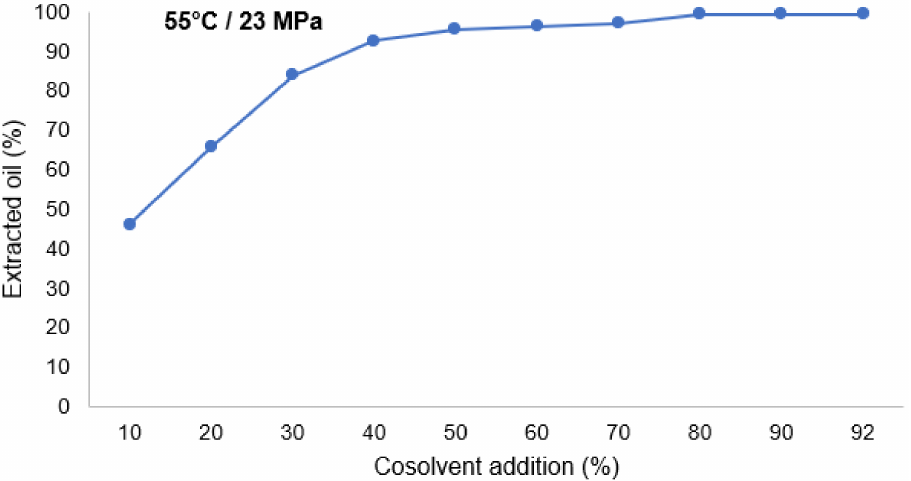
Figure 4. Effect of ethanol cosolvent addition (%) on the extracted oil (extraction of quinoa flour with supercritical CO 2 at 23 MPa and 55 ◦